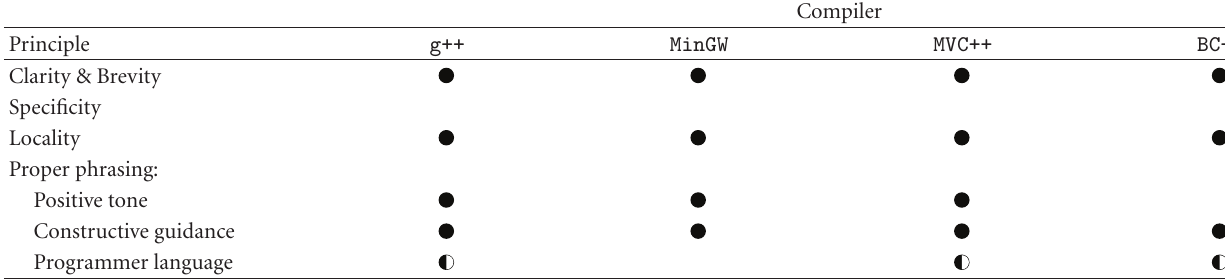
Table 5: Which principles are violated by which compilers for error message 1.